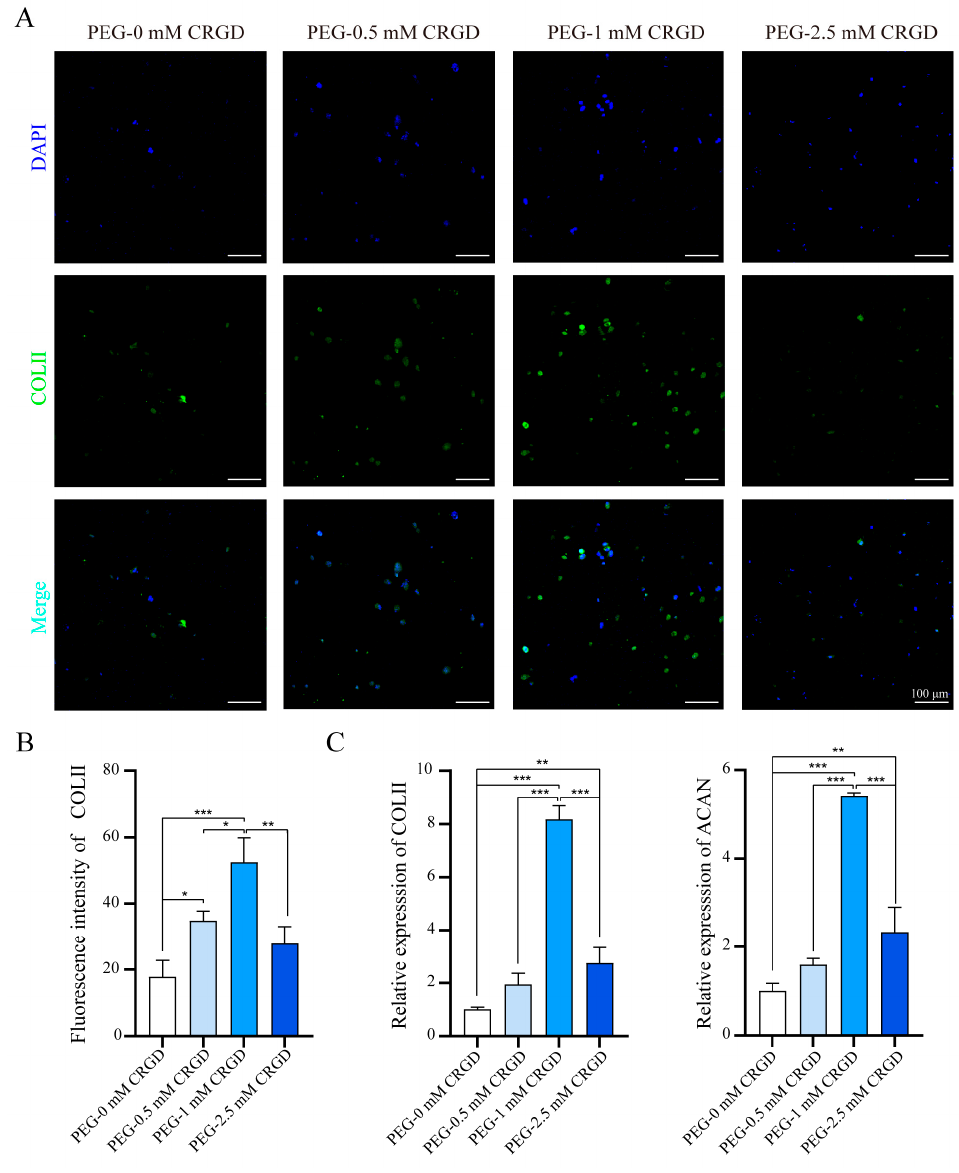
Figure 4. ( A ) Figure 4. The chondrogenic differentiation of PBMSCs in PEG-CRGD hydrogels. ( A ) Immunofluo- rescence staining of COL II expression in PBMSCs encapsulating PEG-CRGD hydrogels. Scale bar = 100 µm. ( B ) The quantification of COL II. ( C ) The relative mRNA expression of chondrogenic genes (COL-II and ACAN) in PBMSCs. * p < 0.05, ** p < 0.01, *** p < 0.001.